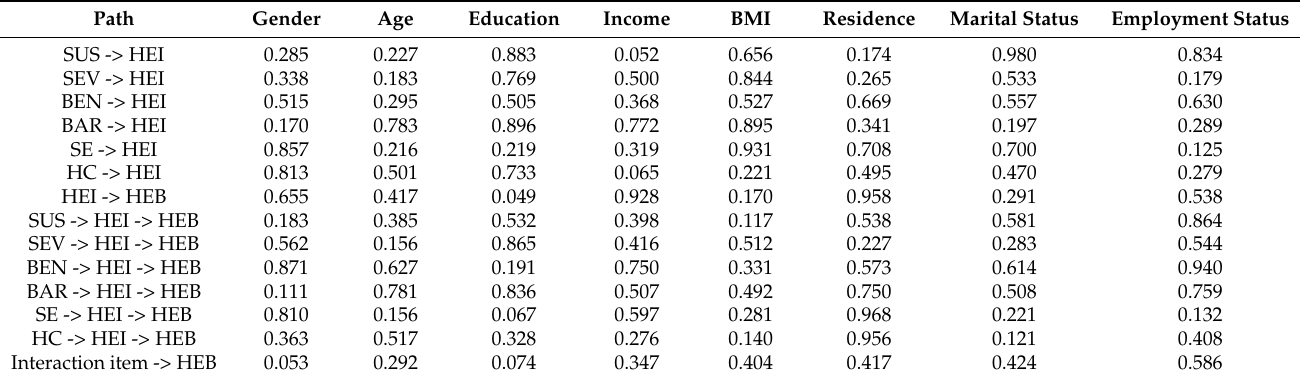
Table 6. Multi-group analysis.